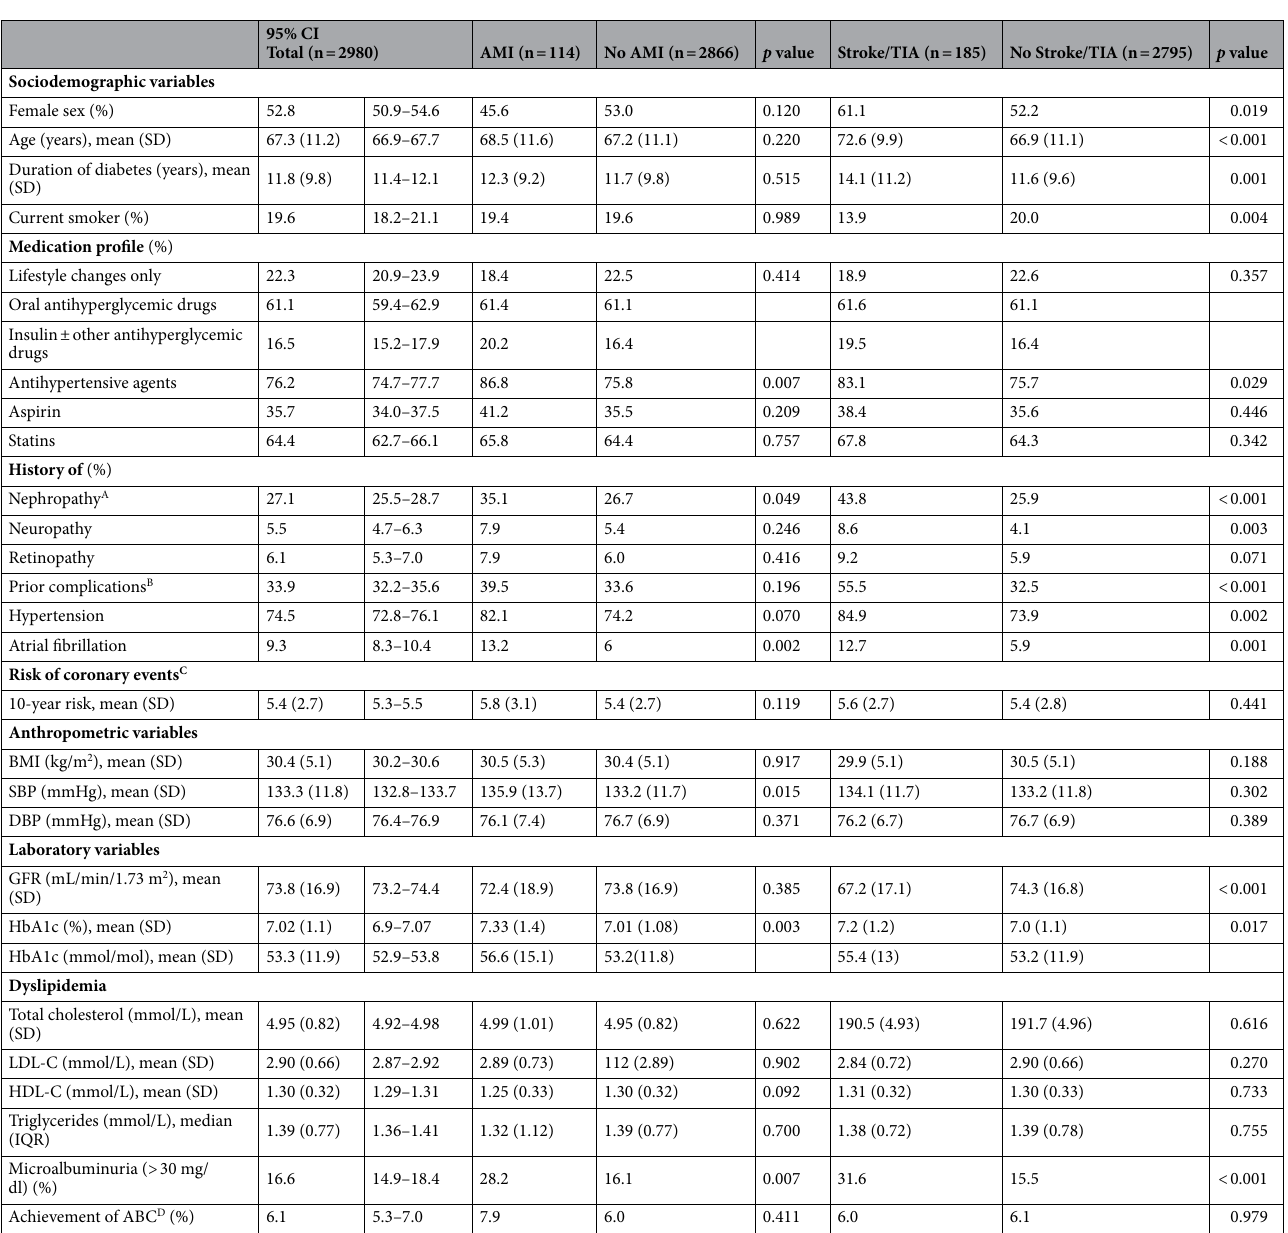
Table 1. Baseline characteristics of the MADIABETES cohort (total population, and according to incident first acute myocardial infarction and incident first stroke/transient ischemic attack). AMI Acute myocardial infarction, TIA Transient ischemic attack, SD Standard deviation, BMI Body mass index, SBP Systolic blood pressure, DBP Diastolic blood pressure, GFR Glomerular filtration rate, HbA1c Glycated hemoglobin, LDL-C Low-density lipoprotein cholesterol, HDL-C High-density lipoprotein cholesterol, IQR Interquartile range. A Nephropathy was defined as GFR lower than 60 mL/min/1.73 m 2 or albuminuria (> 30 mg/dL). B Nephropathy and/or Neuropathy and/or Retinopathy. C Risk of developing coronary events as defined by the adjusted REGICOR function 64 . D Achievement of ABC: HbA1c < 7% + LDL-cholesterol < 2.6 mmol/L + Blood pressure < 130/80